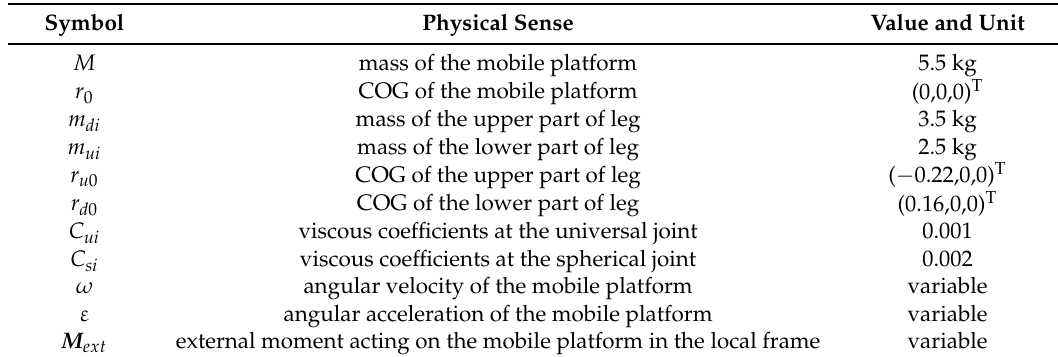
Table 2. Main parameters of the Stewart